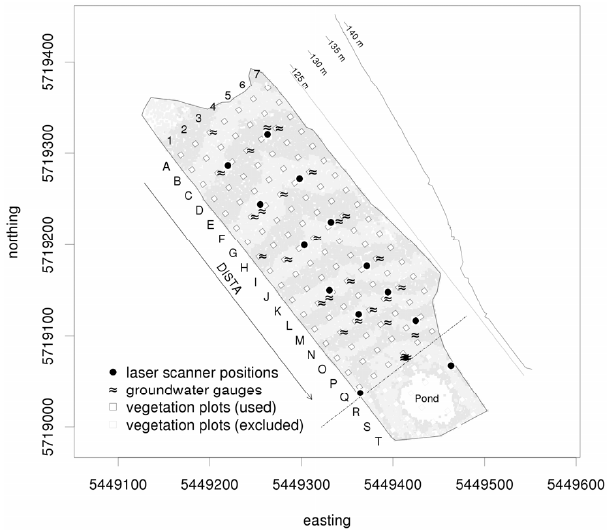
Fig. 1. Map of the Chicken Creek area (with Gauss–Krüger zone 5 coordinates) showing locations of the data sources (vegetation plots, laser scanner positions, groundwater gauge positions) relevant for this study. Vegetation plots are identified by “row” (A–T) and “col- umn” (1–7). In this work only rows A–Q were used. The variable DISTA as shown in the figure indicates the distance of a point from row A. Ground heights a.s.l. are given as mean values from the laser scan in September 2008 around the centre points of vegetation plots A6, F6, L6 and Q6. The height profile along row 4 is given (top right) in the map. It shows the ground elevation as obtained from the laser scans in September